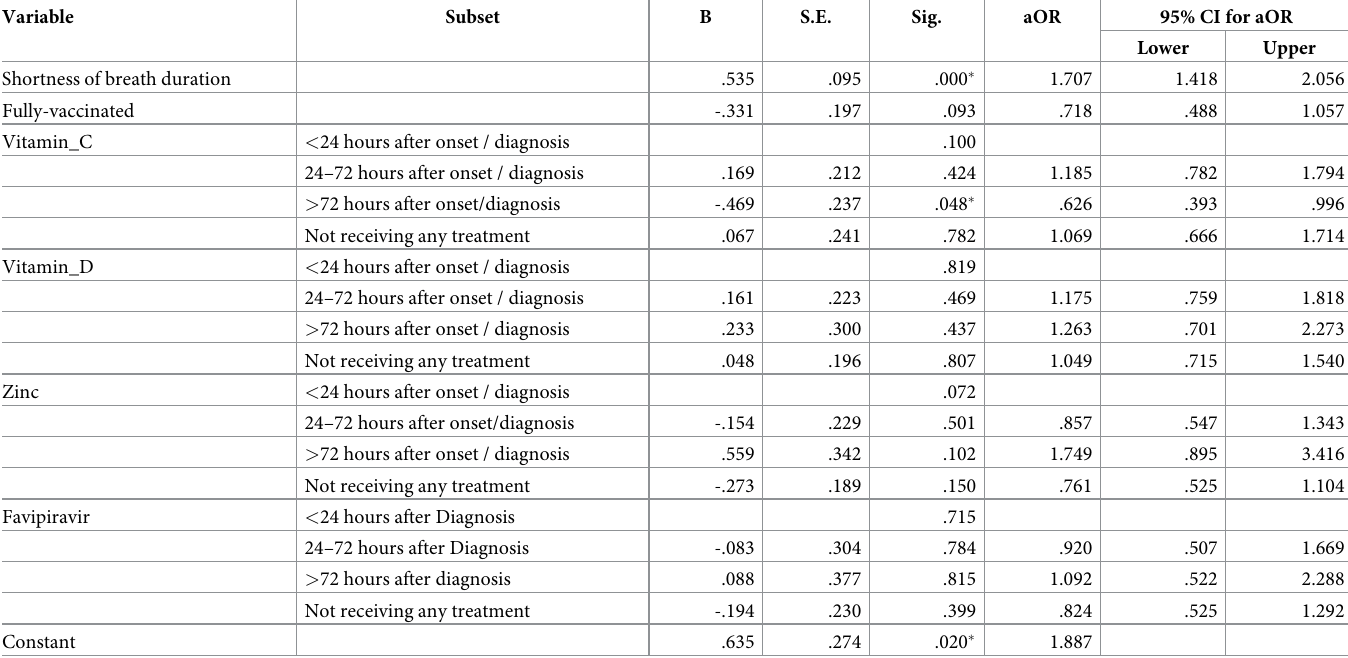
Table 3. Results of binary logistic regression on post-COVID symptoms in 90